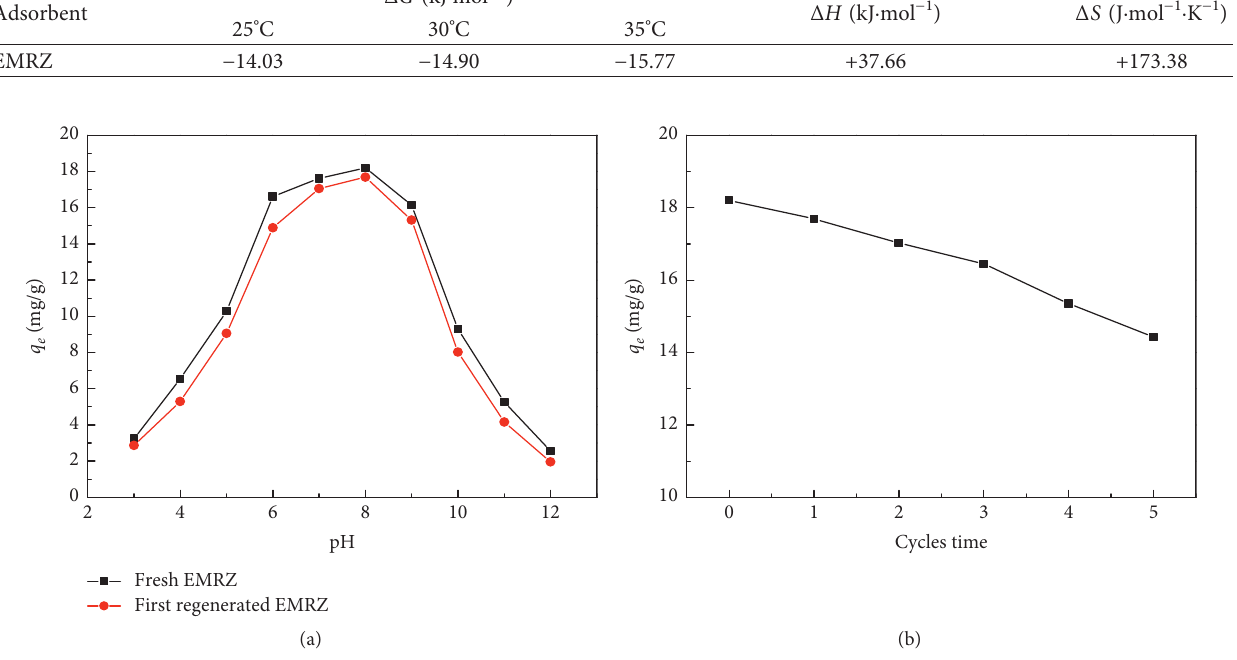
Figure 15: Comparison of ammonium uptake capacity by fresh and regenerated EMRZ. (a) EMRZ dosage � 0.2g/100mL; initial am- monium concentration � 100mg/L; temperature � 25 ° C; contact time � 100min. (b) EMRZ dosage � 0.2g/100 mL; initial ammonium concentration � 100mg/L; temperature � 25 ° C; contact time � 100min; pH value �